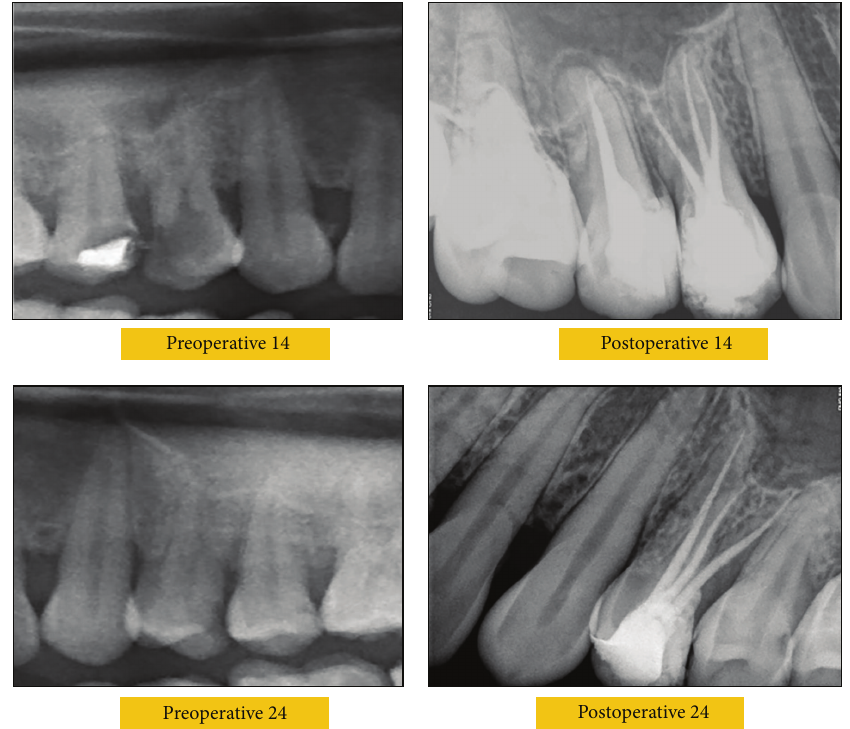
Figure 3: Preoperative and postoperative radiographs of 14 and 24 showing three